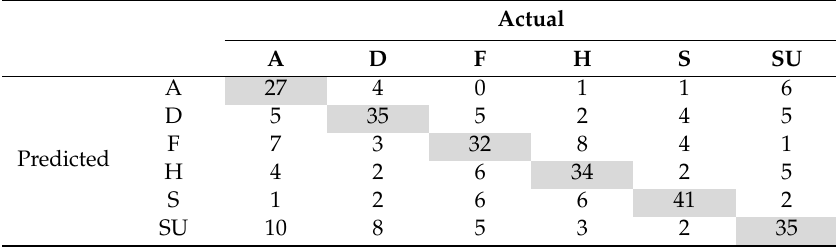
Table 8. Confusion matrix of the RBD group using H 1 feature in PNN classification.